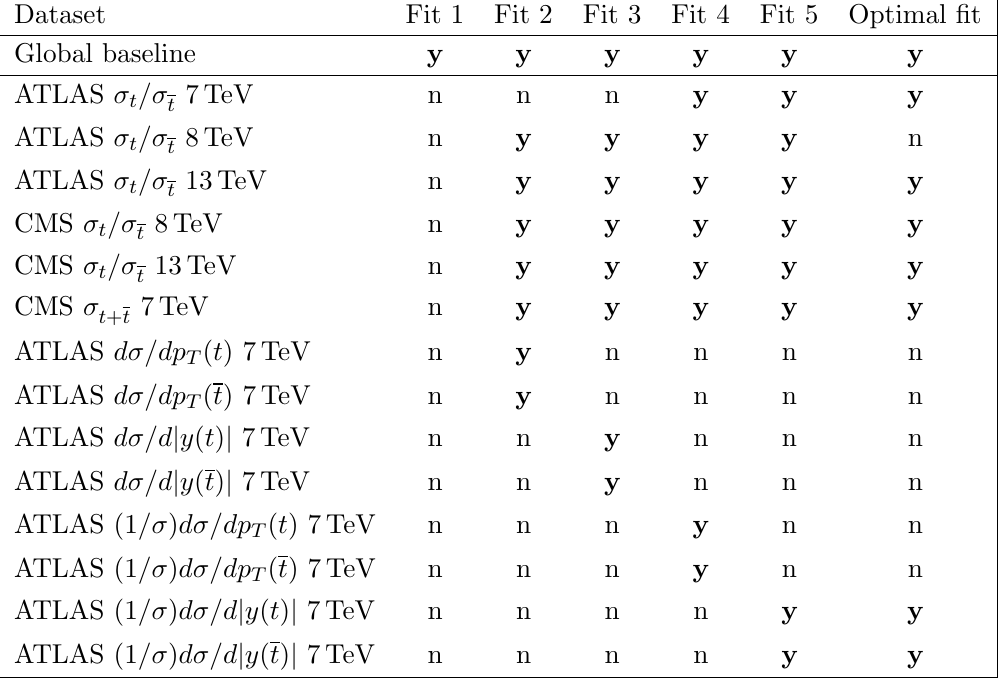
Table 5 . The combinations of data that are included (y) or not (n) in each